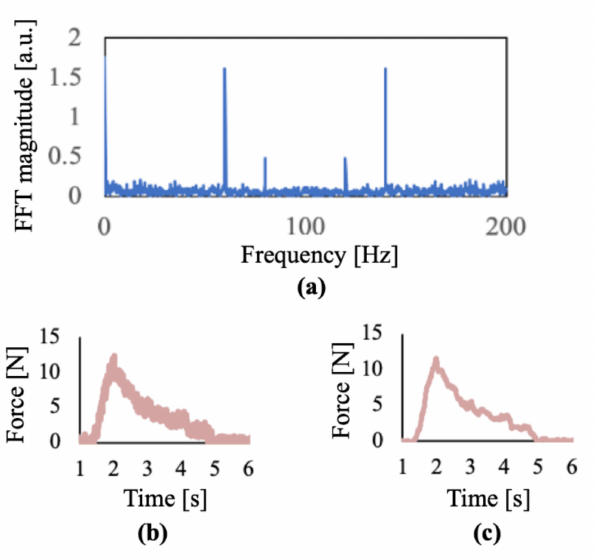
Figure 6. Calibration of can grasp and key turn activities: ( a ) fast Fourier transform of force glove sensor revealing signal noise at 60 Hz and 80 Hz; ( b ) unfiltered sensor data from M3 (middle distal phalanx); ( c ) signals after applying low pass filter (10 Hz). The curve starts inclining when the activity occurs in the